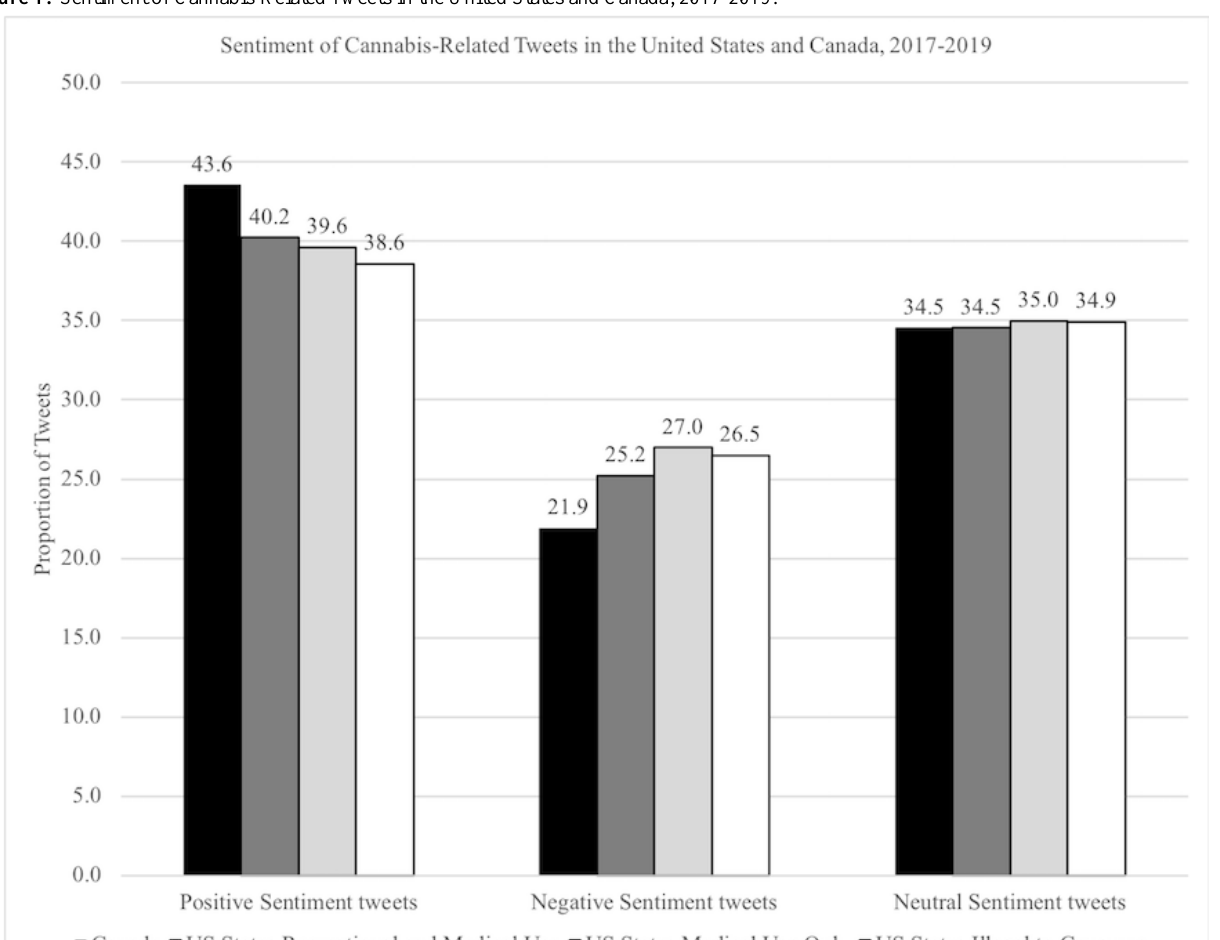
Figure 1. Sentiment of Cannabis-Related Tweets in the United States and Canada,